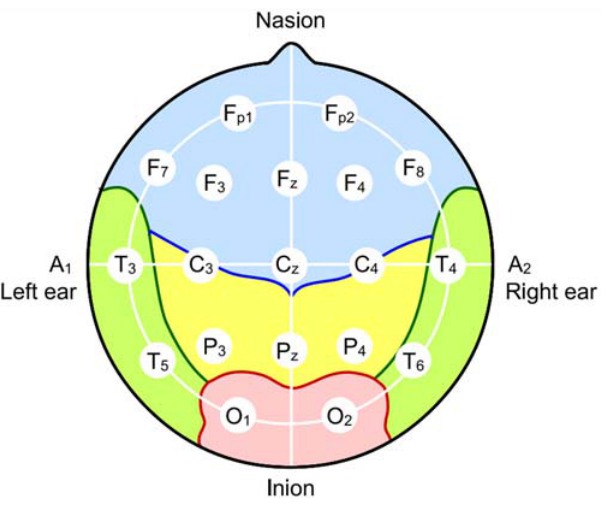
Figure 1. Placement of the electrodes using 10–20 system [49]. Table 1. Description of the emotions that are measured using Epoc+ EEG headset.